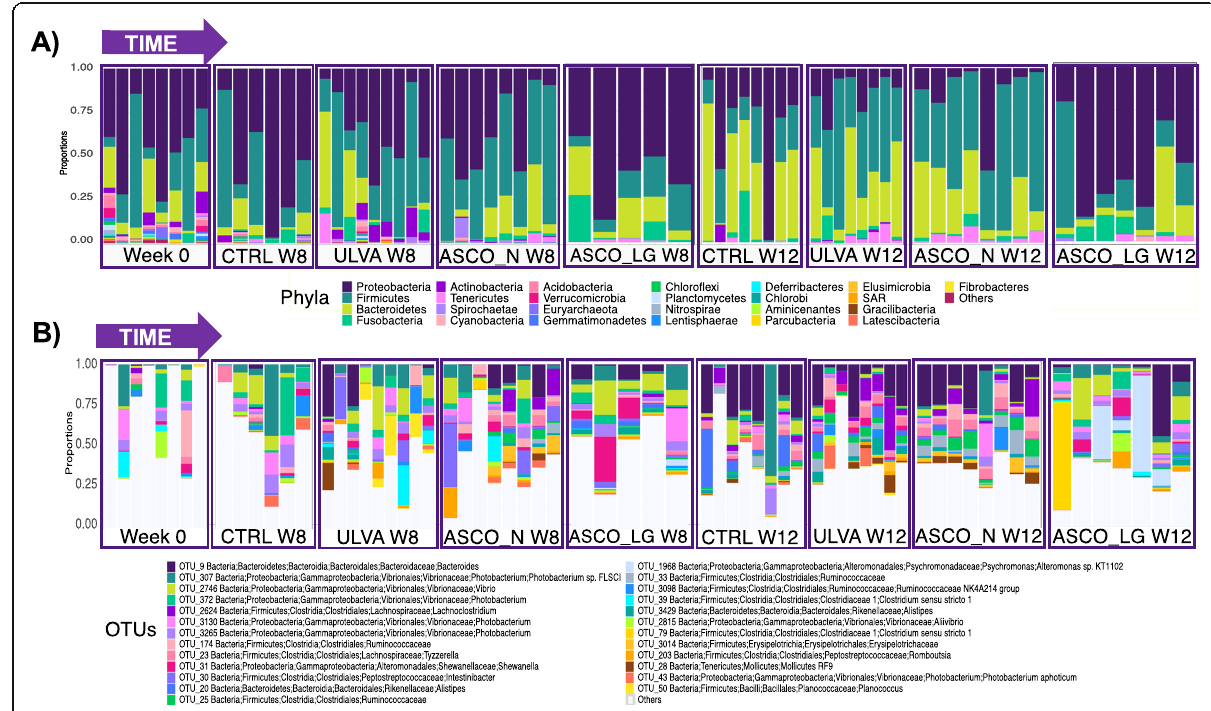
Fig. 2 Horizontal bar-plot showing the relative abundance of the top 25 most abundant, a phyla, and b Operational taxonomic units (OTUs) in the hindgut of juvenile Atlantic cod ordered by the dietary groups over time. “ Others ” represents the remaining lesser abundant